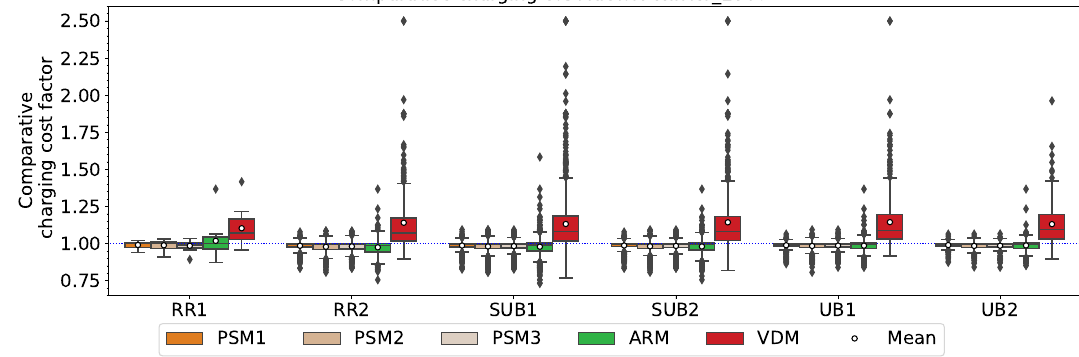
Figure 14. Comparative charging cost factor of EV 80% scenario in